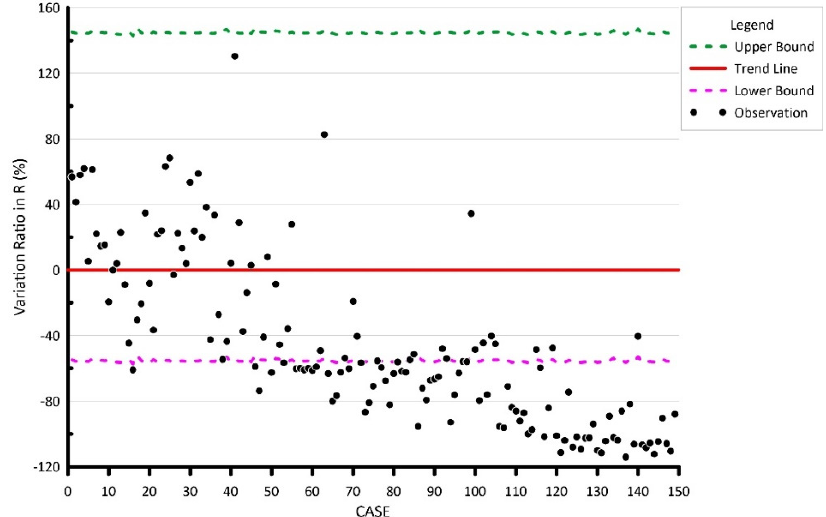
Figure 12. Prediction of rainfall distribution by nonlinear analysis of 79 LSL cases.